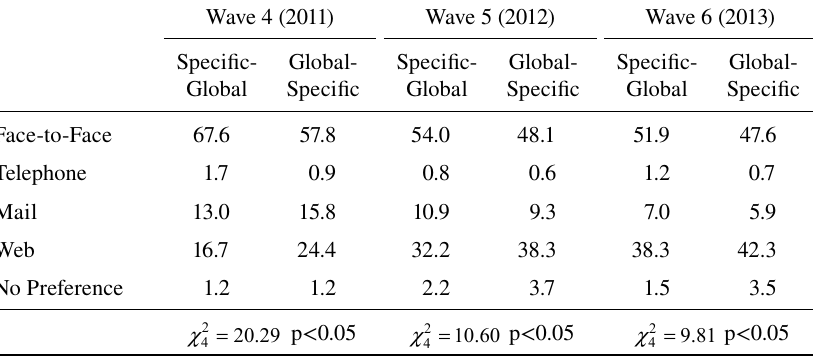
Mode by Preference by Question Ordering and Wave (in Percent) Wave 4